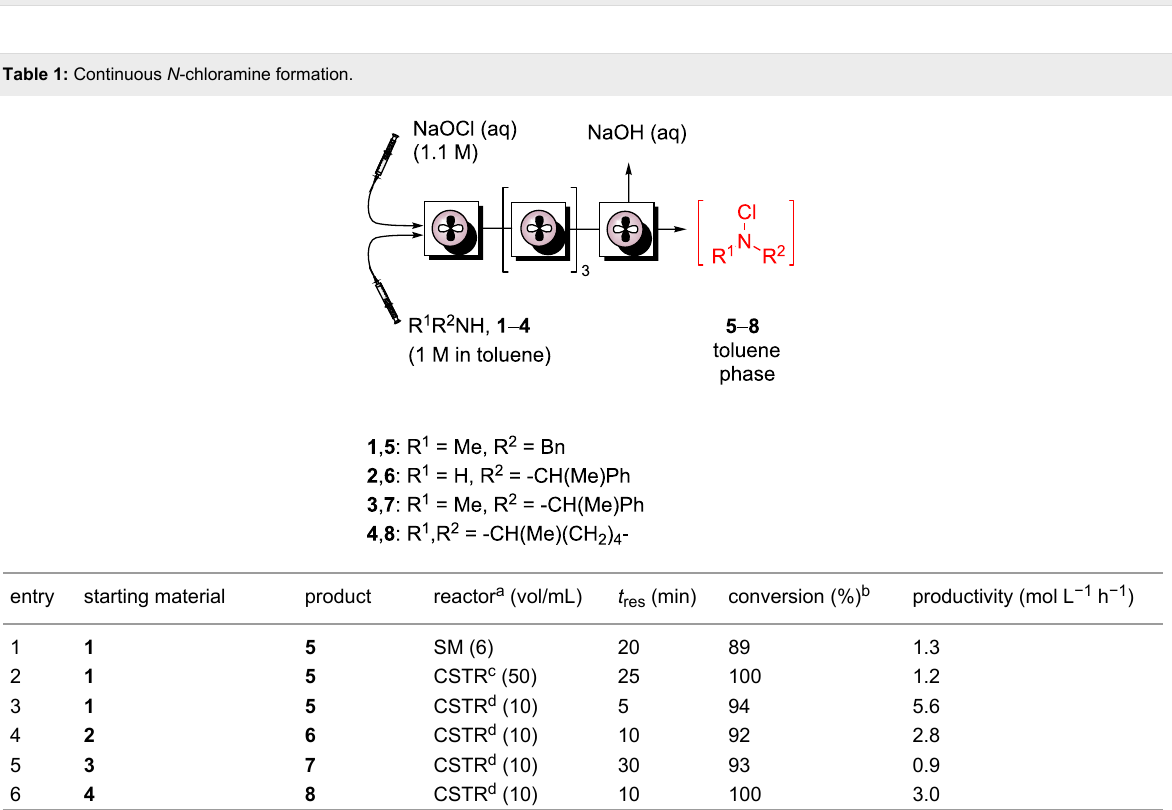
Figure 2: Left: Laboratory scale CSTR developed by our group [8]. Right: 5-stage CSTR configuration using co-feeds of amine in toluene and aqueous NaOCl.